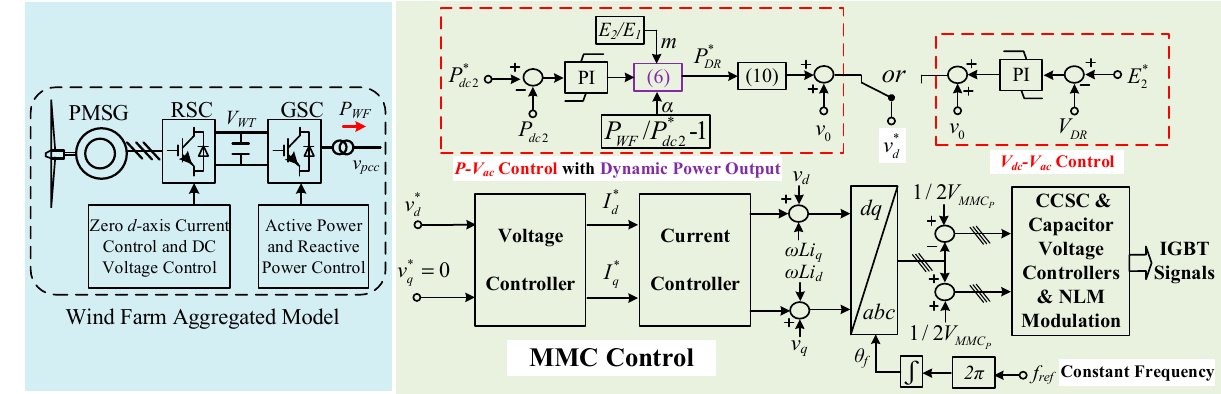
Figure 2. Converter power ratings for different system configurations versus different power ratio α and DC voltage ratio m: ( a ) MMC power rating; ( b ) DR power rating.